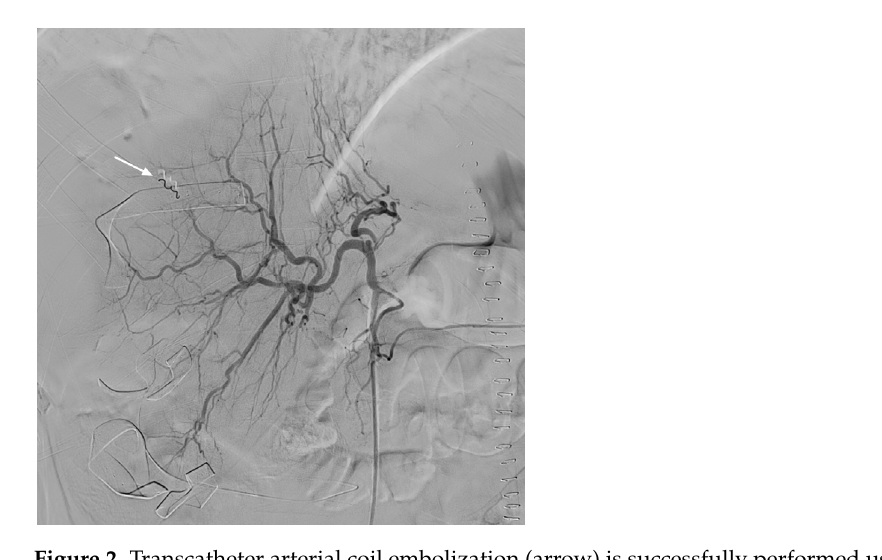
Figure 2. Transcatheter arterial coil embolization (arrow) is successfully performed using the isola- tion technique.